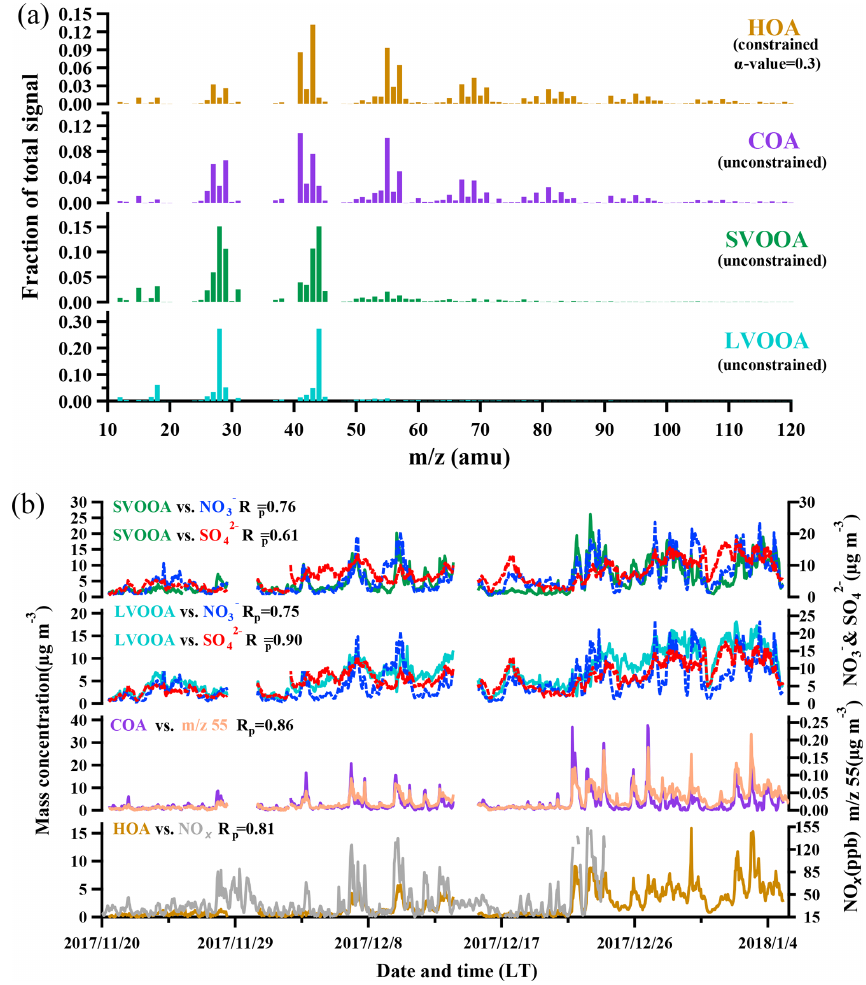
Figure 4. The mass spectra and time series of the four OA components (HOA, COA, SVOOA, and